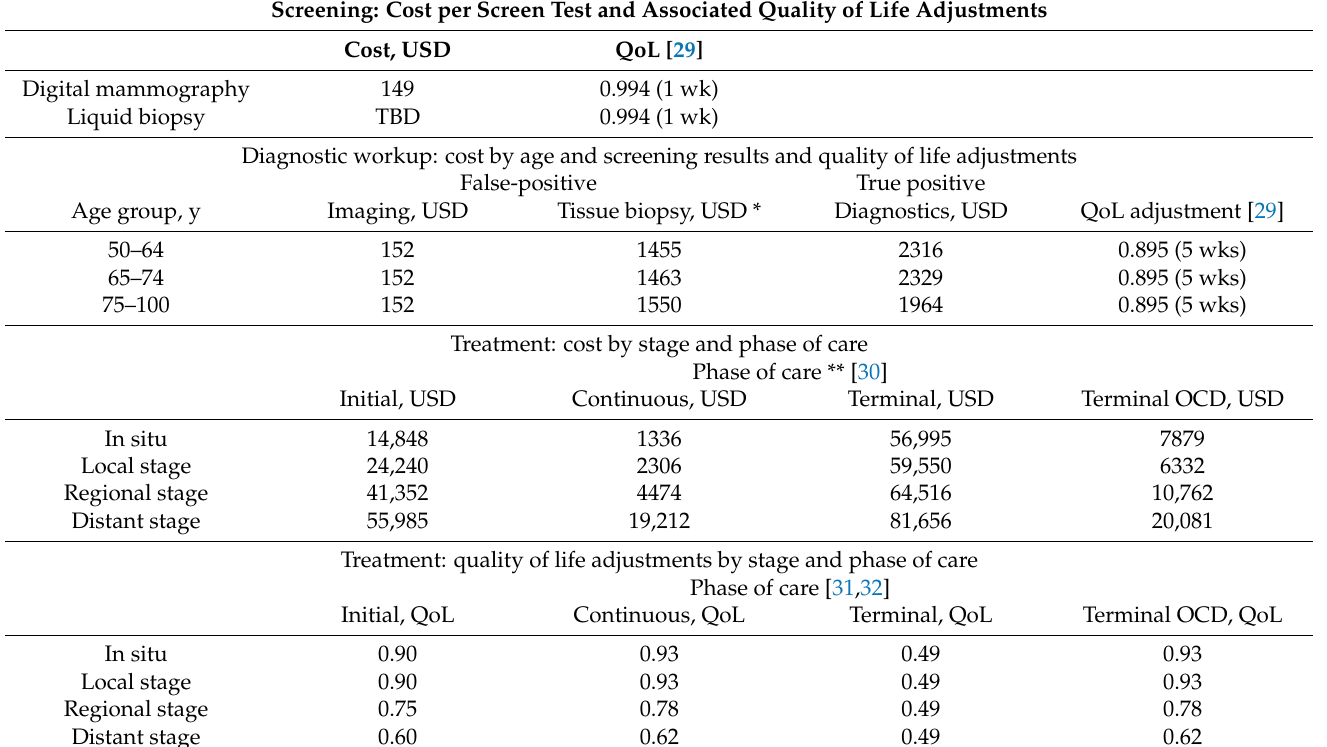
Table 2. MISCAN-Fadia breast cancer model inputs. Screening, diagnostic work-up, and care-related costs (USD), and quality of life effects